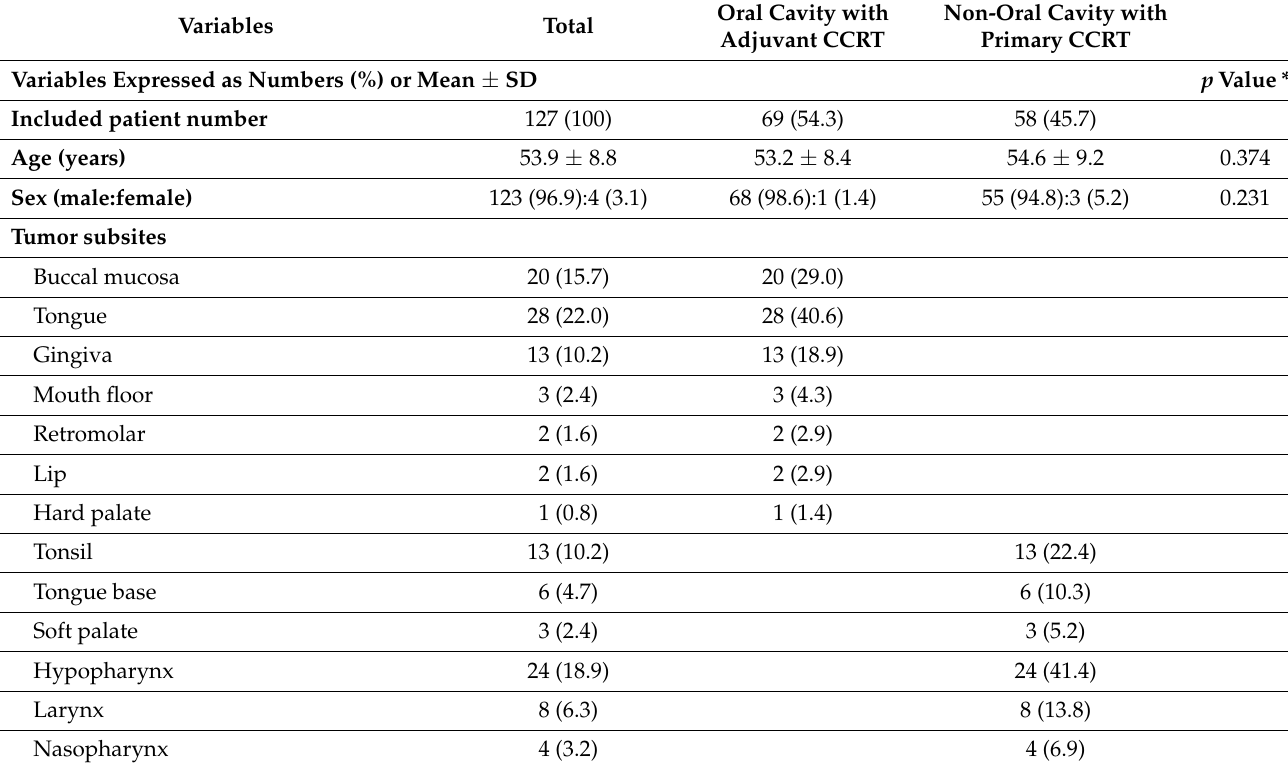
Figure 1. The CONSORT diagram. Incomplete CCRT was defined as patients who dropped out during the CCRT course or could not complete at least four cycles of weekly cisplatin (40 mg/m 2 ) commitants with planned radiotherapy (64–72 Gy). Patients with incomplete data indicated that they failed to complete the required DXA examinations or scheduled blood tests; CCRT, concurrent chemoradiotherapy; DXA, dual-energy X-ray absorptiometry; LAHNC, locally advanced head and neck cancer. Table 1. Baseline and treatment characteristics of 127 LAHNSCC patients treated by